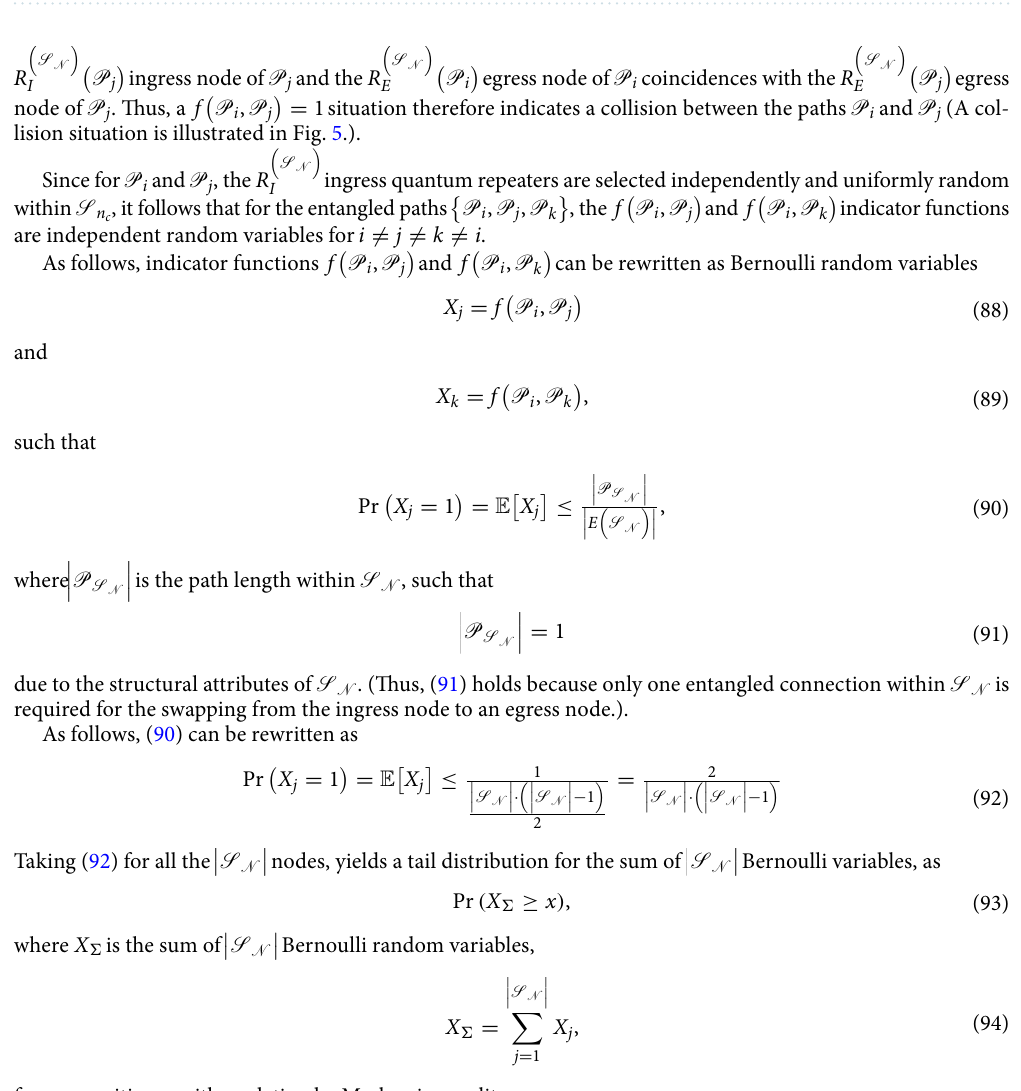
Figure 5. A collision of entangled paths in the strongly-entangled structure. The ingress and egress quantum repeaters associated with the paths within the strongly-entangled structure coincide. Entangled path P i is depicted by a red dashed line, and entangled path P j is depicted by a blue dashed